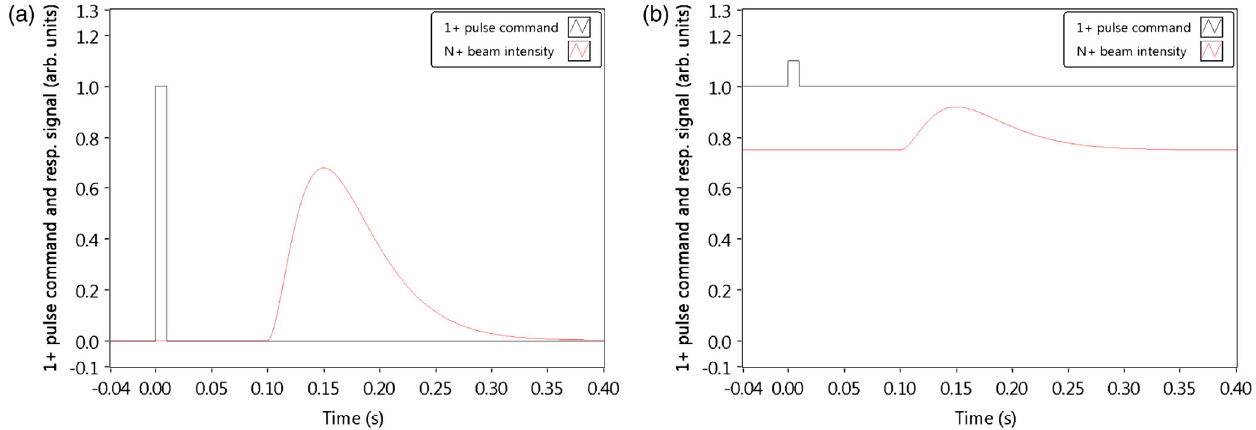
FIG. 10. Principle of the methods to probe the plasma at buffer gas equilibrium (a) and final state equilibrium